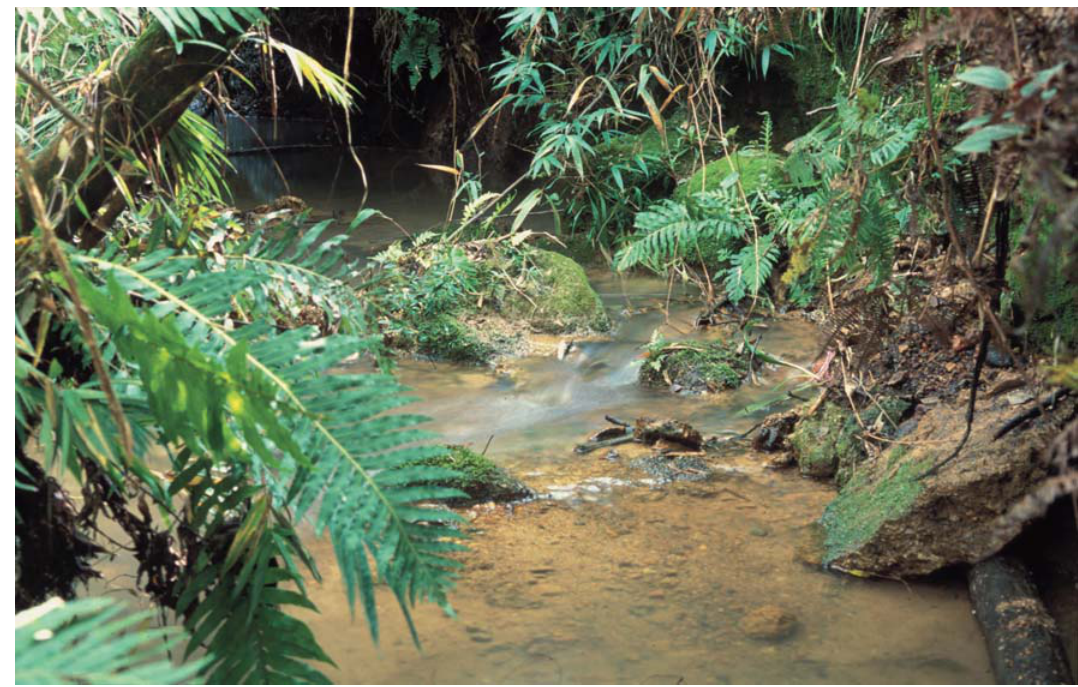
Fig. 10. View of the type locality of Trichomycterus maracaya , a streamlet with limonite bed at the foothill of the Morro do Ferro (about 46º31’50’’S, 21º46’45’’W), município de Poços de Caldas, Minas Gerais, southeastern